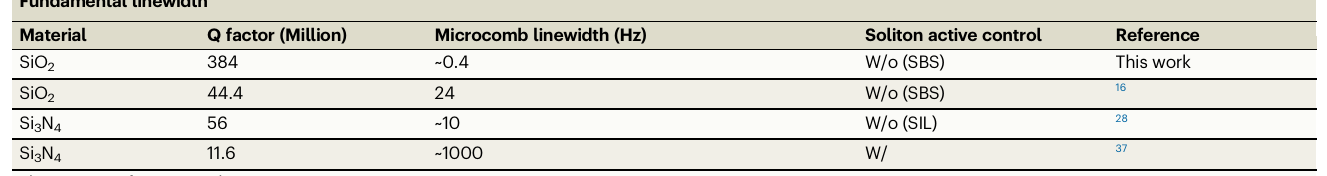
Table 2 | Comparison of DKS microcomb performances Fundamental linewidth